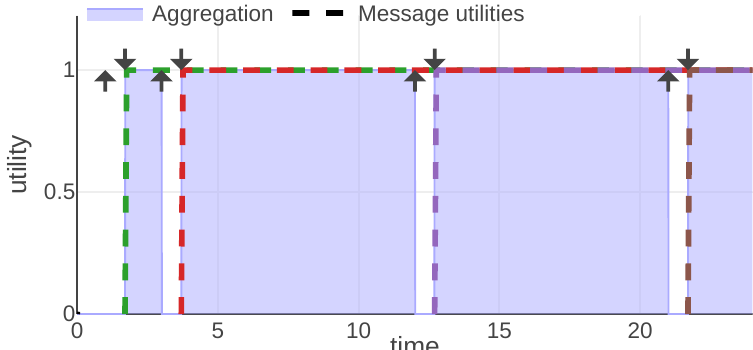
Figure 4. A status and U status functions plotted for a mission example. c (cid:13) 2019 IEEE. Reprinted, with permission, from